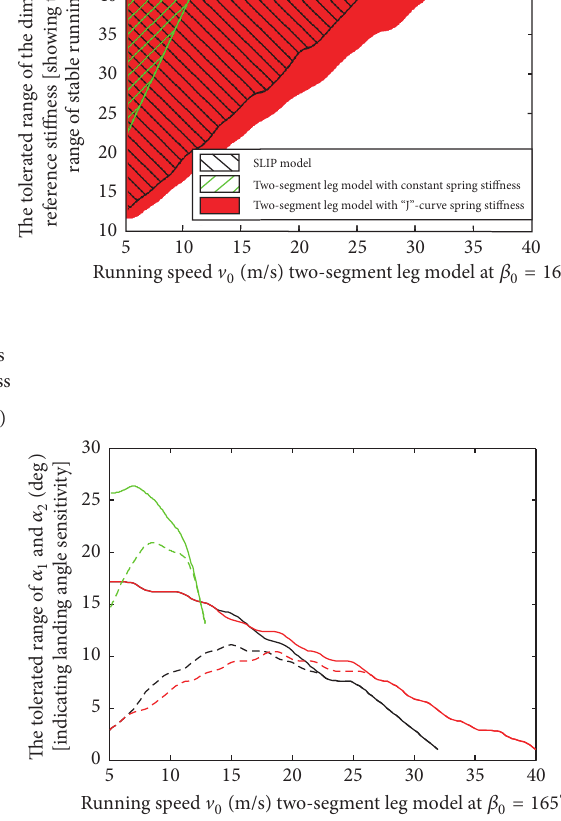
𝛼 1 in the SLIP model 𝛼 1 in the two-segment leg model with constant spring stiffness 𝛼 1 in the two-segment leg model with “J”-curve spring stiffness 𝛼 2 in the SLIP model 𝛼 2 in the two-segment leg model with constant spring stiffness 𝛼 2 in the two-segment leg model with “J”-curve spring stiffness